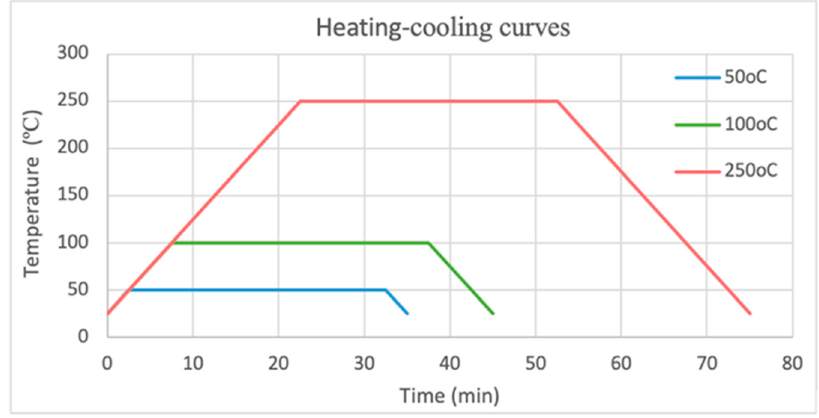
Figure 4. Temperature–time curves of thermal loading before the tension testing (heating process, holding time 30 min at 50, 100 and 250 °C, cooling process to RT = 25 °C).